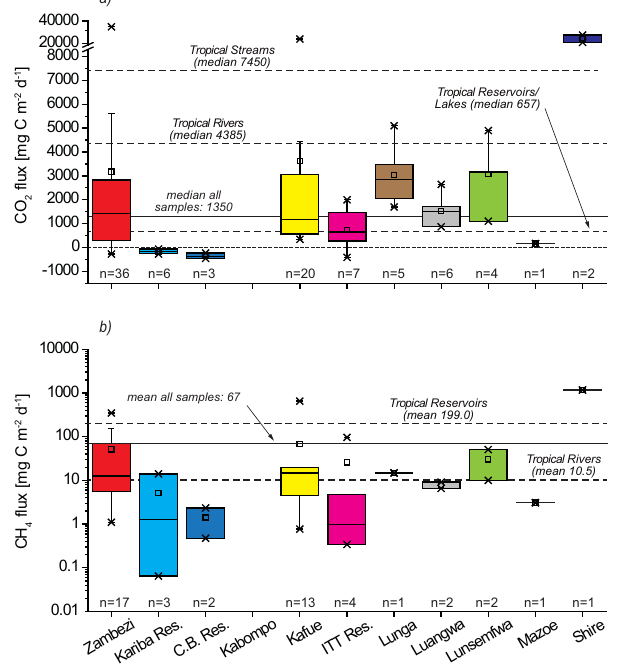
Figure 9. Measured range in (a) CO 2 fluxes and (b) CH 4 fluxes (note the log scale in the latter) for the Zambezi mainstem, tribu- taries and reservoirs. Box plots show the range, percentile, median, mean and outliers. Dashed lines in (a) represent global median CO 2 efflux for tropical rivers, streams and lakes/reservoirs based on Auf- denkampe et al. (2011), while in (b) they represent the global mean CH 4 emission for tropical rivers and reservoirs as suggested by Bastviken et al. (2011). Solid lines represent median CO 2 emissions (a) and mean CH 4 flux (b) of all sites and over the entire sampling period.